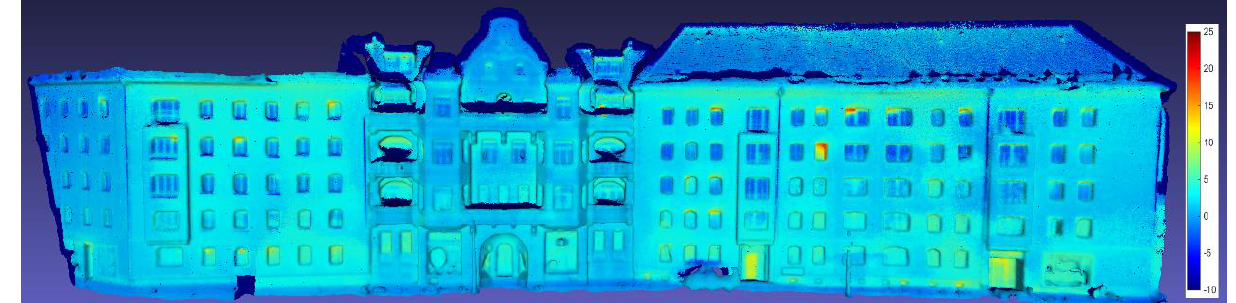
Figure 7. Texture mapping result after temperature correction and Gauss